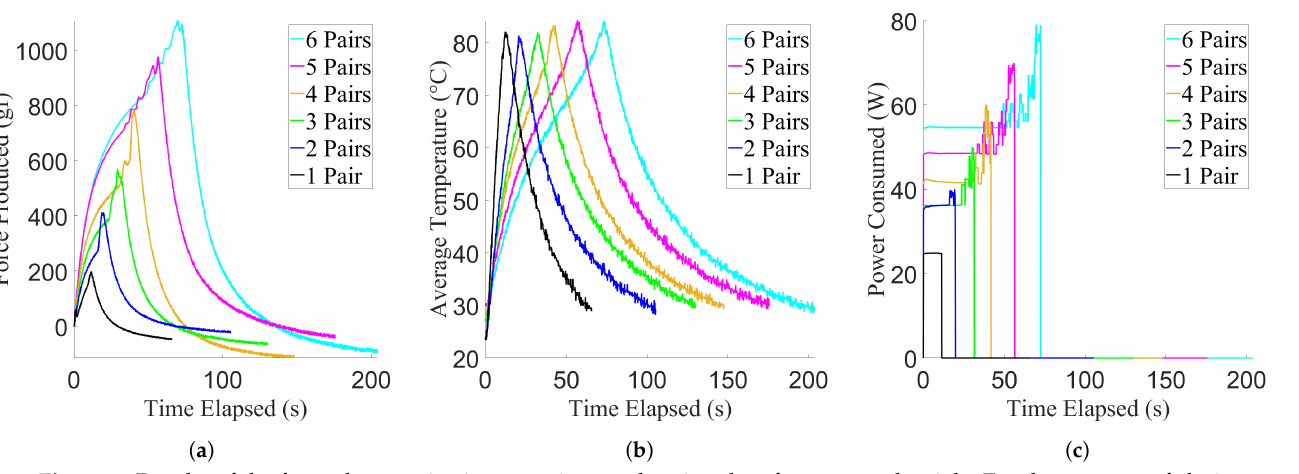
Figure 8. Results of the force characterisation experiment, showing data from example trials. For the purpose of clarity, example curves were used due to low variance between trials. ( a ) Force production of the actuator. ( b ) Temperature achieved by the actuator. ( c ) Power consumed by the